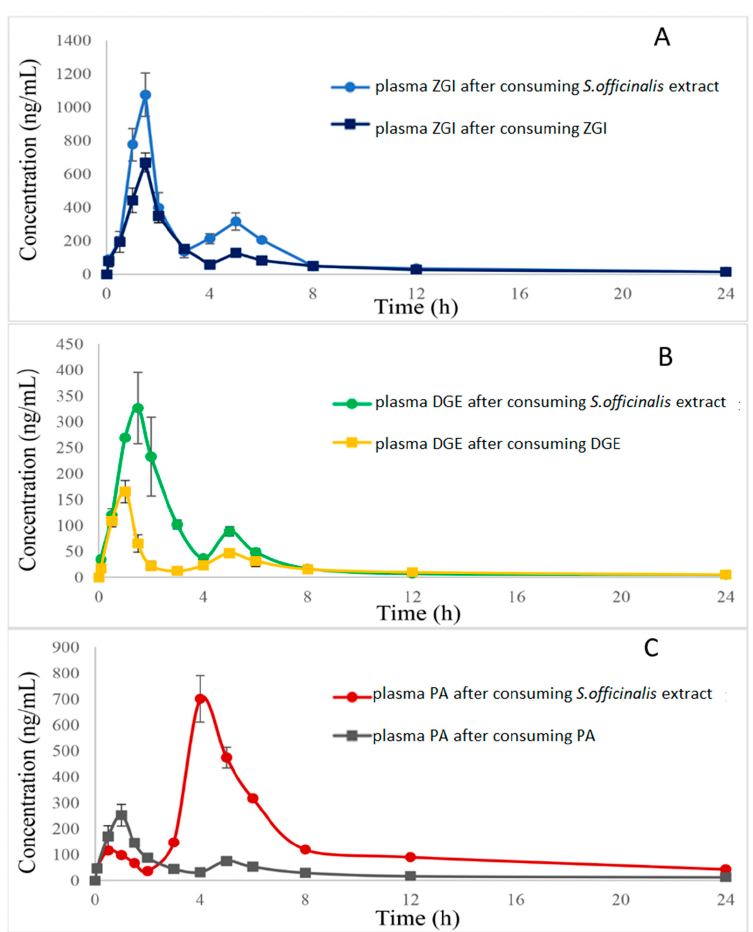
Figure 3. ( A ): Mean plasma concentration–time curve of ZGI in rats after oral administration of ZGI and S. officinalis extract; ( B ): Mean plasma concentration–time curve of DGE in rats after oral administration of DGE and S. officinalis extract; ( C ): Mean plasma concentration–time curve of PA in rats after oral administration of PA and S. officinalis extract.